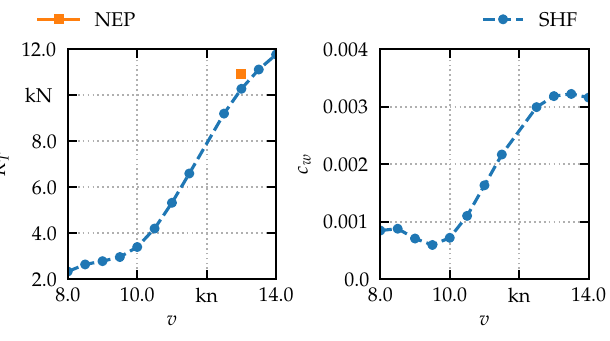
Figure 3. Resistance curve computed with SHIPFLOW XPAN (SHF) for the baseline and cross- checked with RANS solver Neptuno